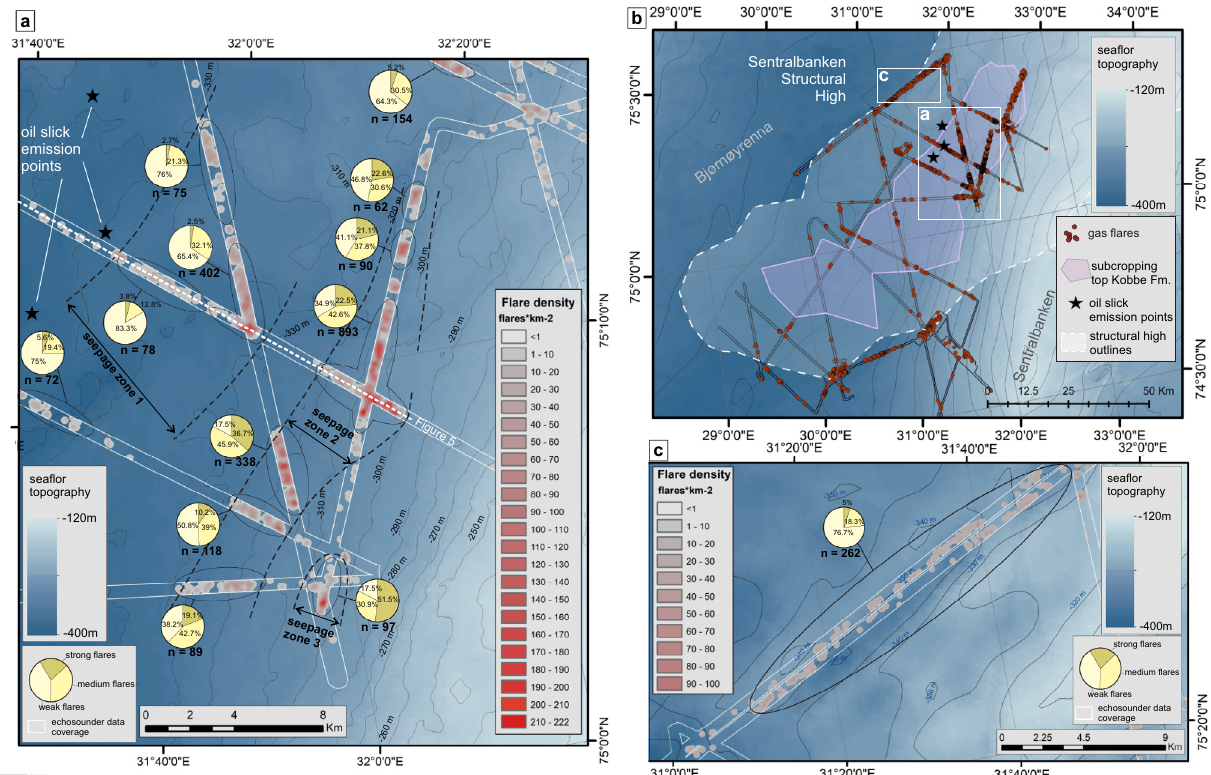
Fig. 4 | Density of gas fl are appearance and ratios between strong, moderate and weak fl ares. Multibeam bathymetric data are shown in monochromatic color scale.IBCAOV4griddedbathymetricdata 84 areshowninbluecolorscale. a Central